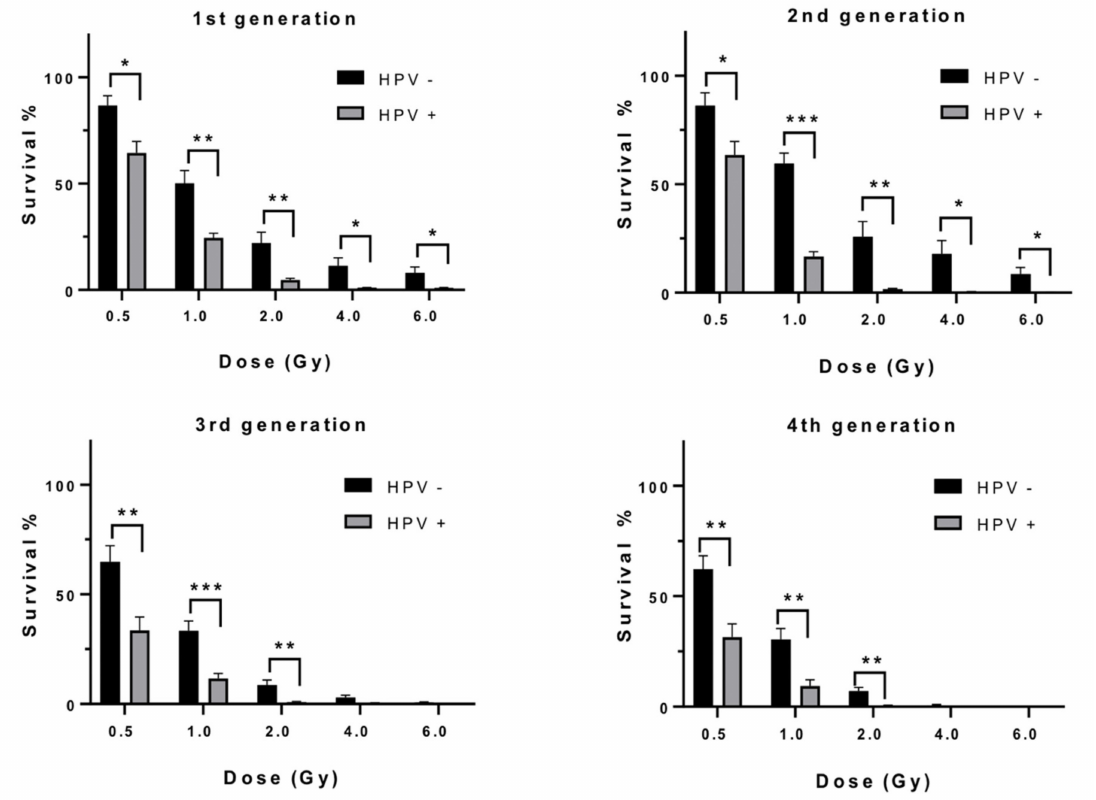
Figure 2. Surviving fractions of HPV negative versus HPV positive HNSCC cells, as a function of dose for each generational group. Error bars shown as standard error of the mean (SEM), 3 lines per HPV status. Significance, p values, * ≤ 0.05, ** ≤ 0.01, *** ≤